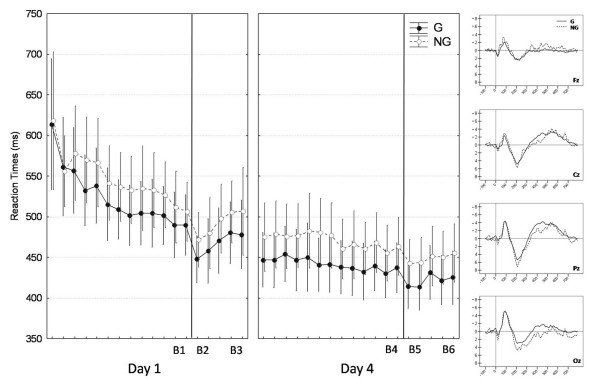
Sequence learning effects. Left panel: Average reaction times (and standard errors of the mean) per block for grammatical (G; filled circles) and non grammatical (NG; open circles) stimuli at Day 1 and Day 4. Errors bars are standard errors of the mean. Vertical bars represent the 30-minute break within the two learning sessions at Day 1 and Day 4. Right panel: Grammaticality effects. Average ERPs for grammatical (G; solid line) and non grammatical (NG; dashed line) stimuli at Fz, Cz, Pz and Oz electrodes.